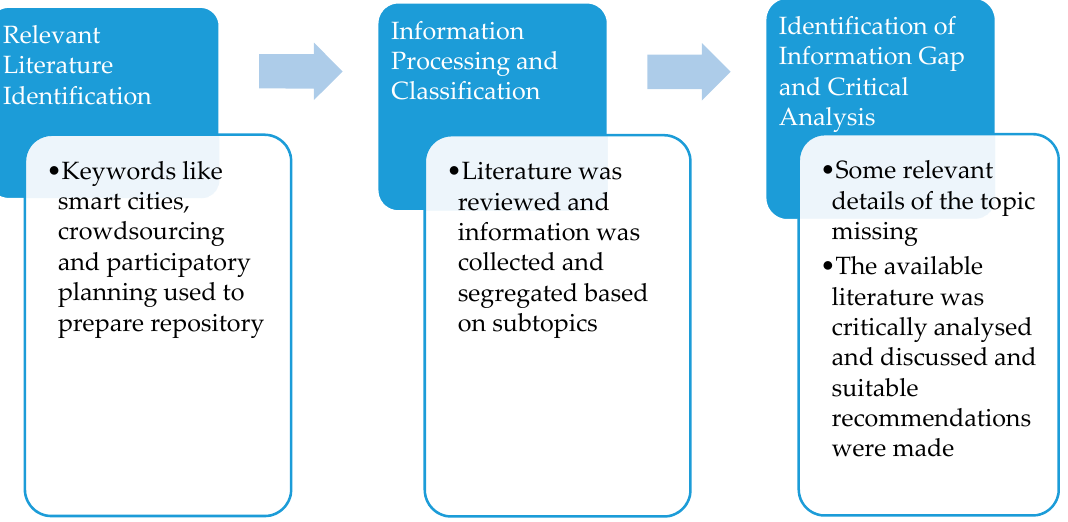
Figure 3. Research guideline: literature review, information processing and analysis.